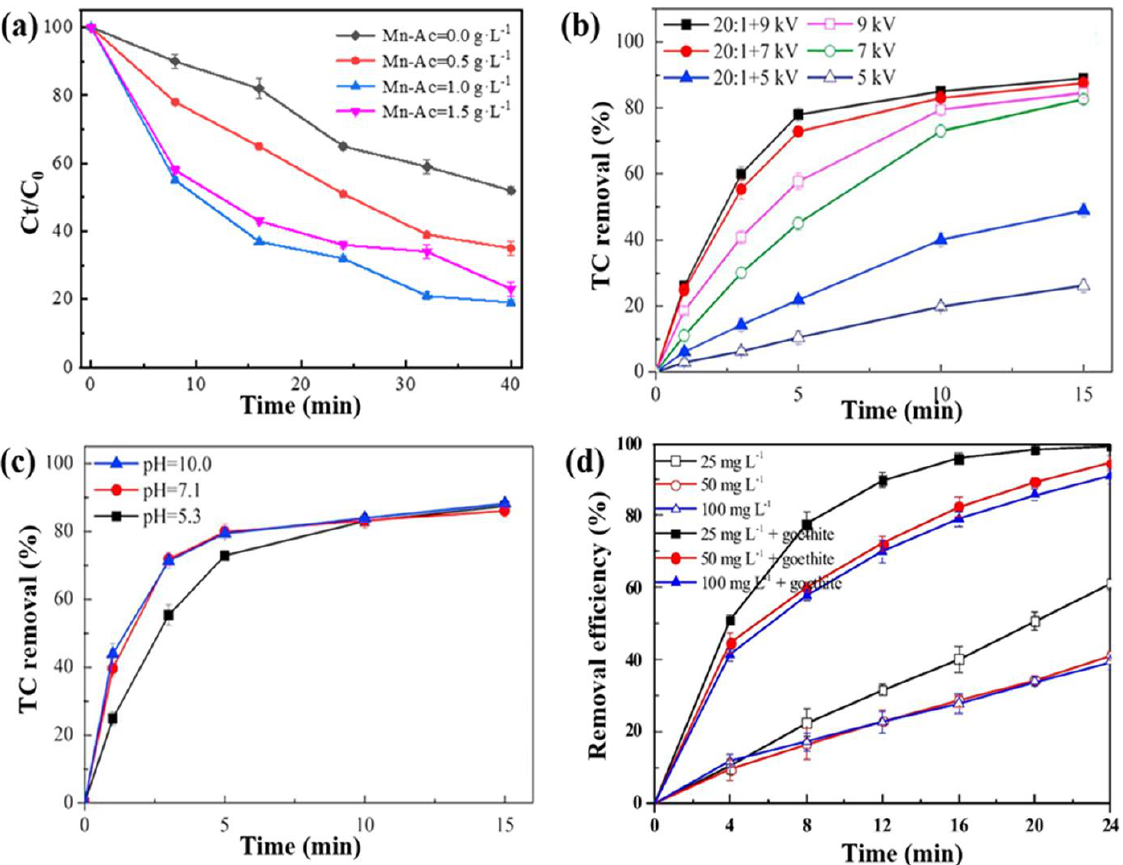
Figure 10. Effect of ( a ): catalyst dosage [64]; ( b ): peak voltage [102]; ( c ): initial pH of solution [102]; ( d ): reactant concentration [47].